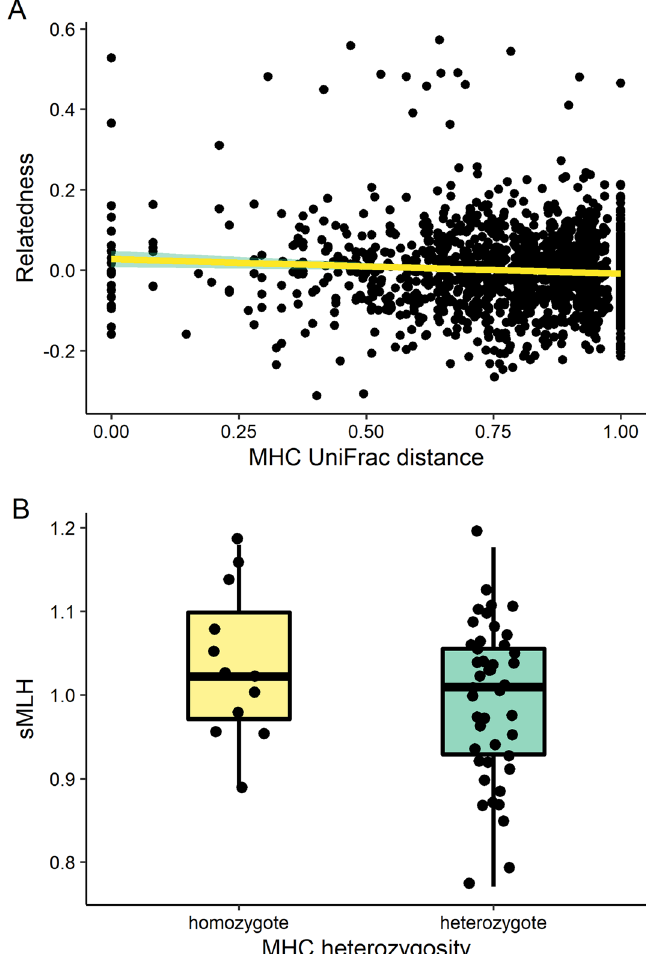
Figure 4. Relationship between ( A ) pairwise MHC UniFrac distance and microsatellite relatedness; ( B ) MHC heterozygosity and microsatellite standardised multilocus